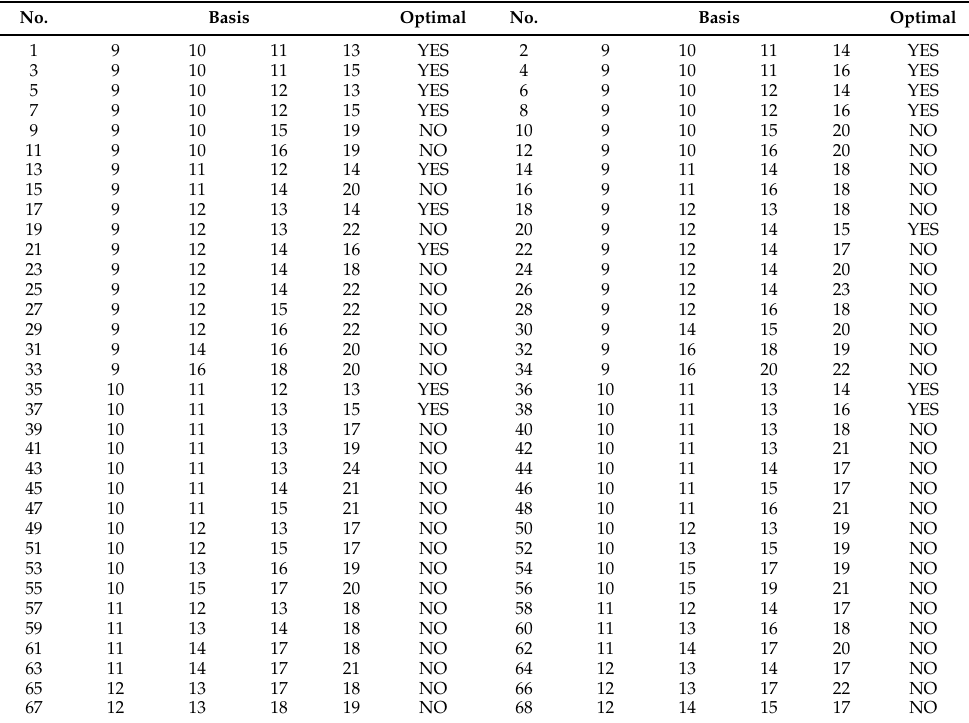
Table A1. The bases remained after the filtering of the 4-dimensional case containing no vectors from the first 8 vectors, i.e., containing only diagonal vectors. (The columns of matrix A are referred by their indices from 1 to